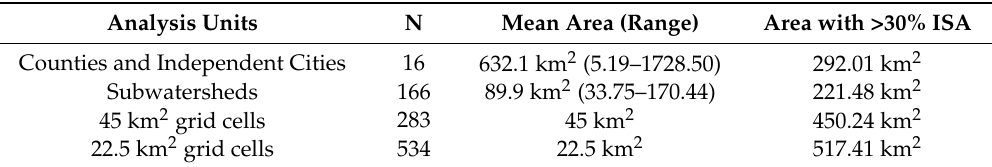
Table 3. Statistics for four scales of analysis unit across the study area.